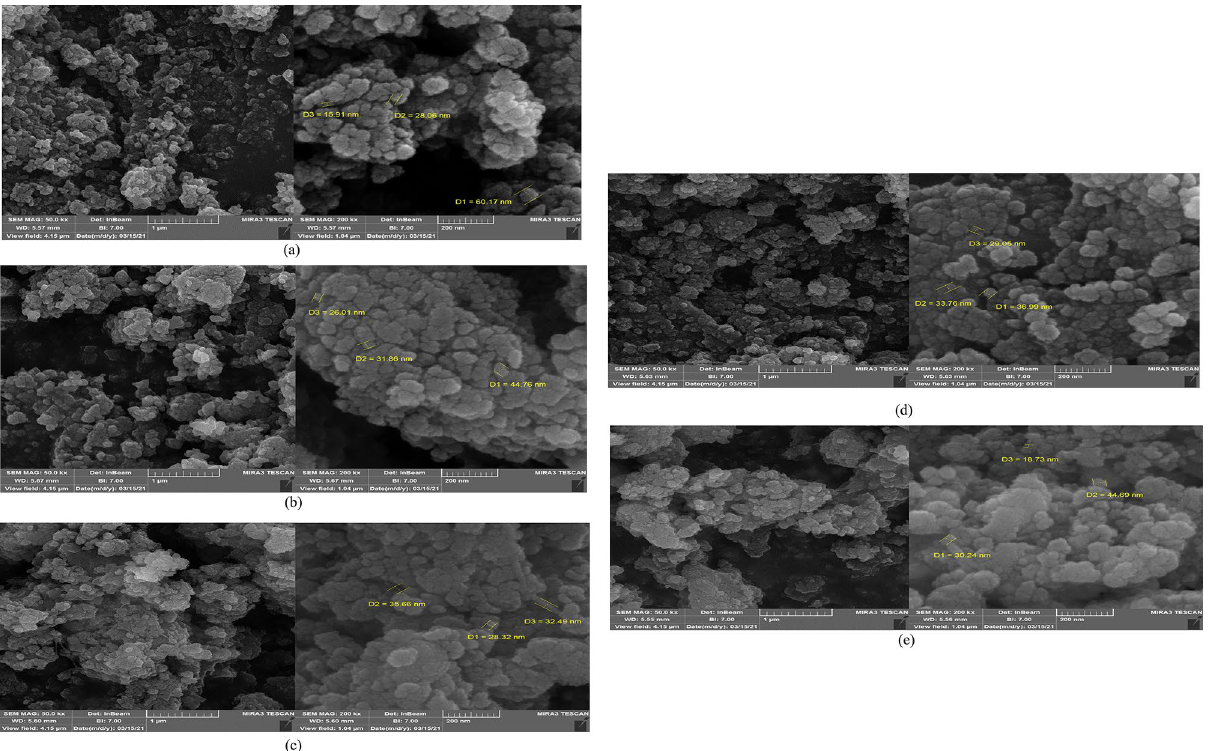
Figure 3. FE-SEM images of ( a ) TiO 2 nanoparticle ( b ) T1 ‒ Z1 ( c ) T1 ‒ Z1/CS ( d ) T2 ‒ Z1/CS ( e ) T1 ‒ Z1/CS1 ‒ Gr2